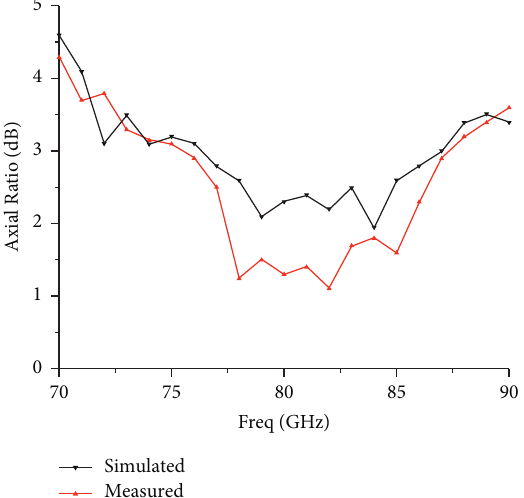
Figure 17: Simulation and measurement results of the axial ratio of the antenna array.